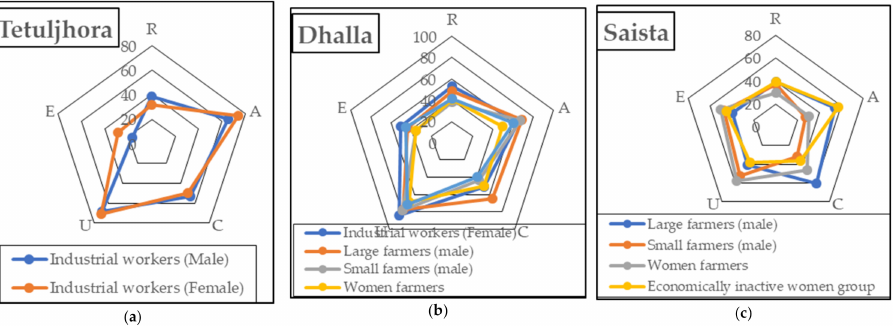
Figure 3. Present WPI pentagrams for different livelihood groups in the ( a ) Tetuljhora; ( b ) Dhalla; and ( c ) Saista